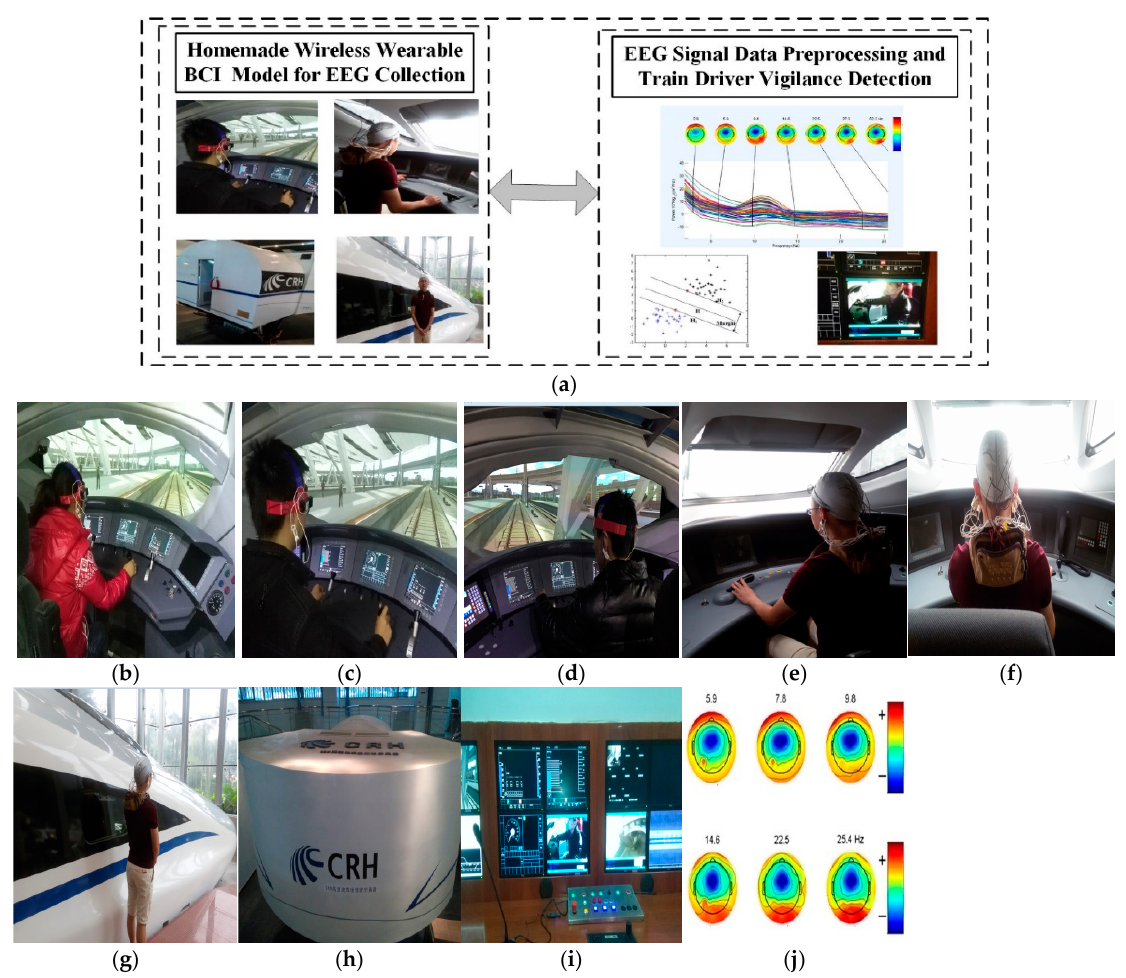
Figure 11. Experimental environment. ( a ) Experimental prototype; ( b ) EEG collection experiment; ( c ) EEG collection experiment; ( d ) EEG collection experiment; ( e ) EEG collection experiment; ( f ) EEG collection experiment; ( g ) High-speed train experimental simulator; ( h ) CRH high-speed train simulation cab; ( i ) CRH high-speed train simulation monitoring platform; ( j ) The train driver vigilance detection in experiment.